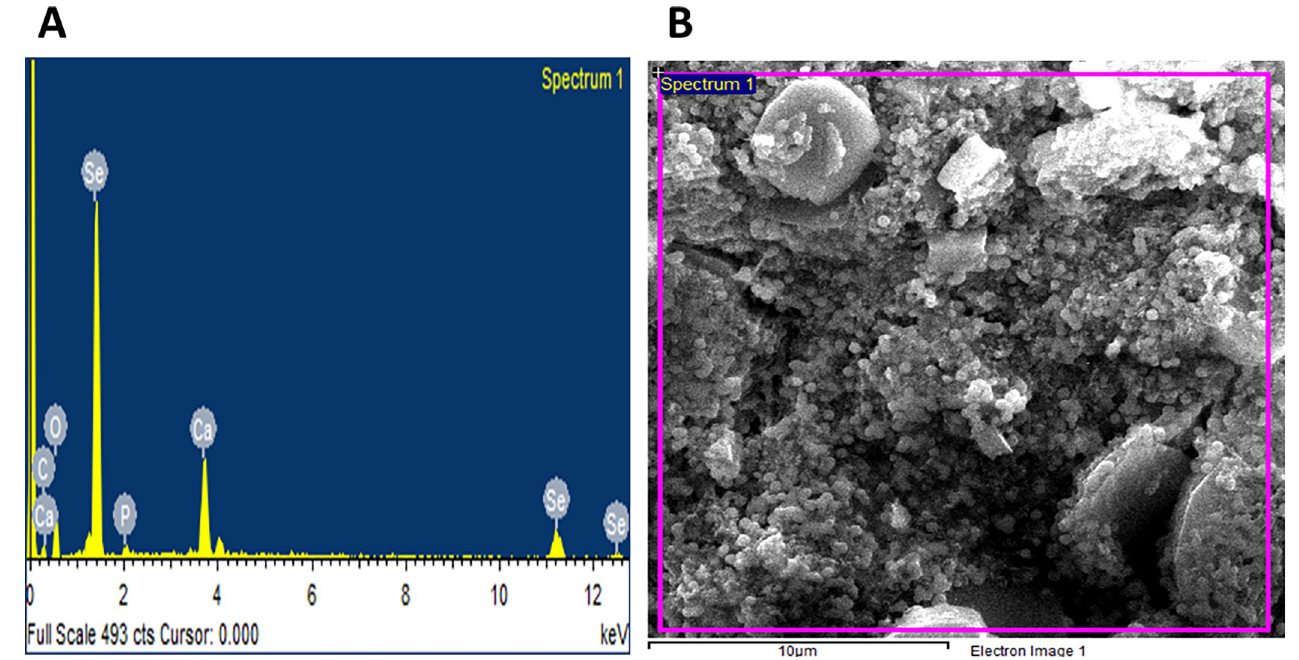
Fig 3. EDX spectrum of the green synthesized SeNPs. https://doi.org/10.1371/journal.pone.0274679.g003 concentrations of SeNPs (see Table 1) were applied as a foliar spray on the two varieties of mango (i.e., V1: Chaunsa and V2: Langra) and physiological parameters were recorded in terms of chlorophyll (photosynthetic pigment) and membrane stability index. The results of